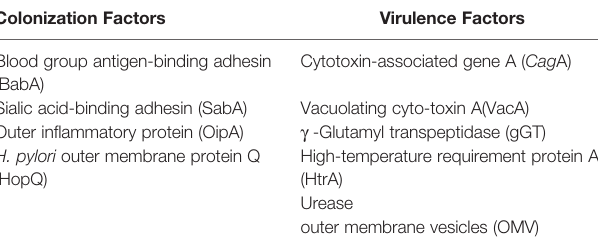
TABLE 2 | The factors involved in the pathogenesis of H. pylori . Colonization